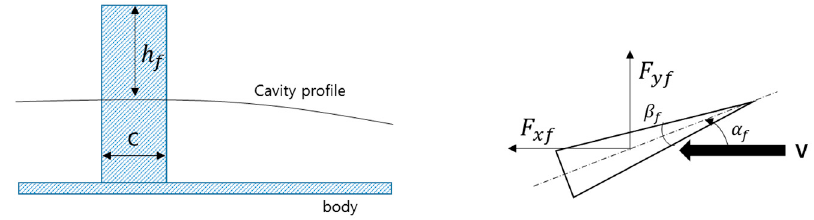
Figure 6. Schematic of the vertical fin.